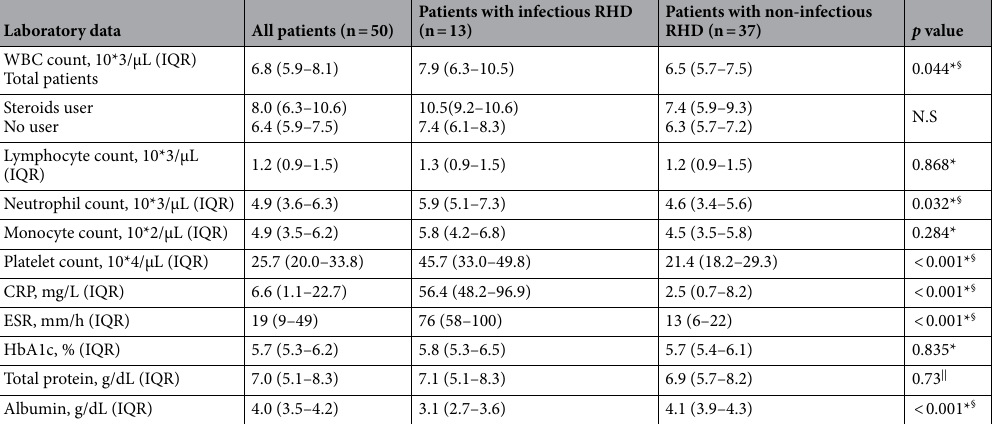
Table 2. Patients laboratory data. CRP C-reactive protein, ESR Erythrocyte sedimentation rate, HbA1c Glycated hemoglobin A1c, IQR Interquartile range, RHD Rapid hip destruction, WBC White blood cell.